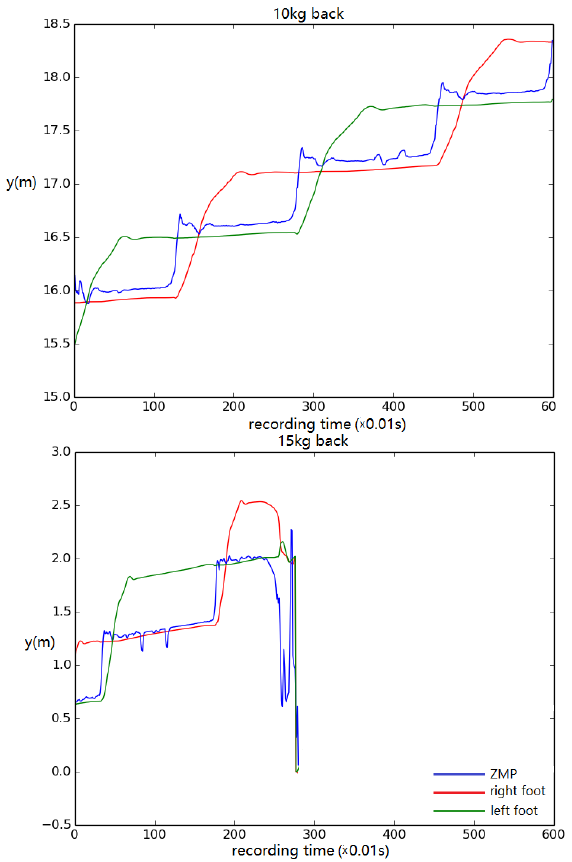
Figure 18. The simulation ( top ) walks with a 10 kg backpack with no change to the controller, but ( bottom ) falls with a 15 kg backpack. Walking distance versus time.